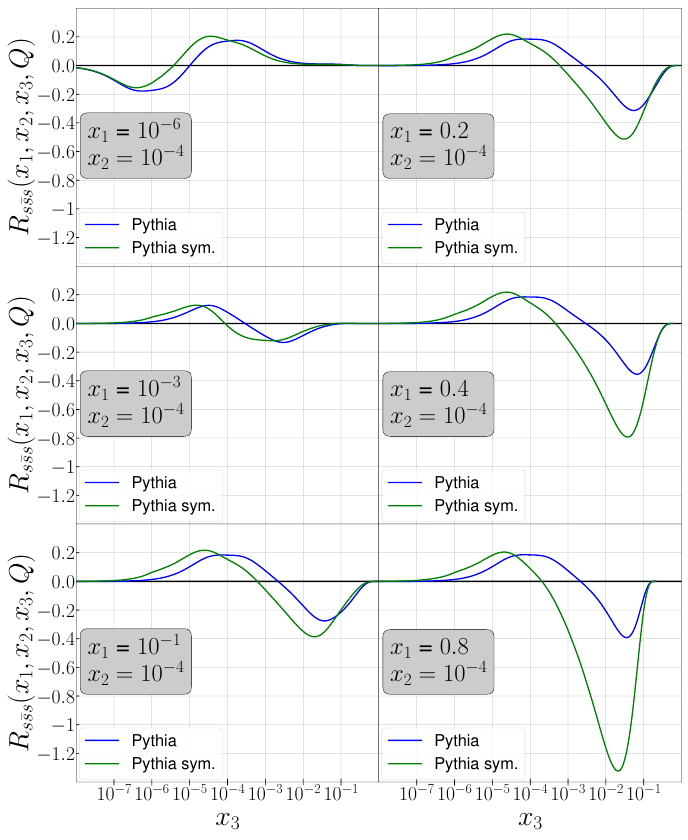
Figure 15 . Same as in figure 14 but for the s ¯ ss flavour